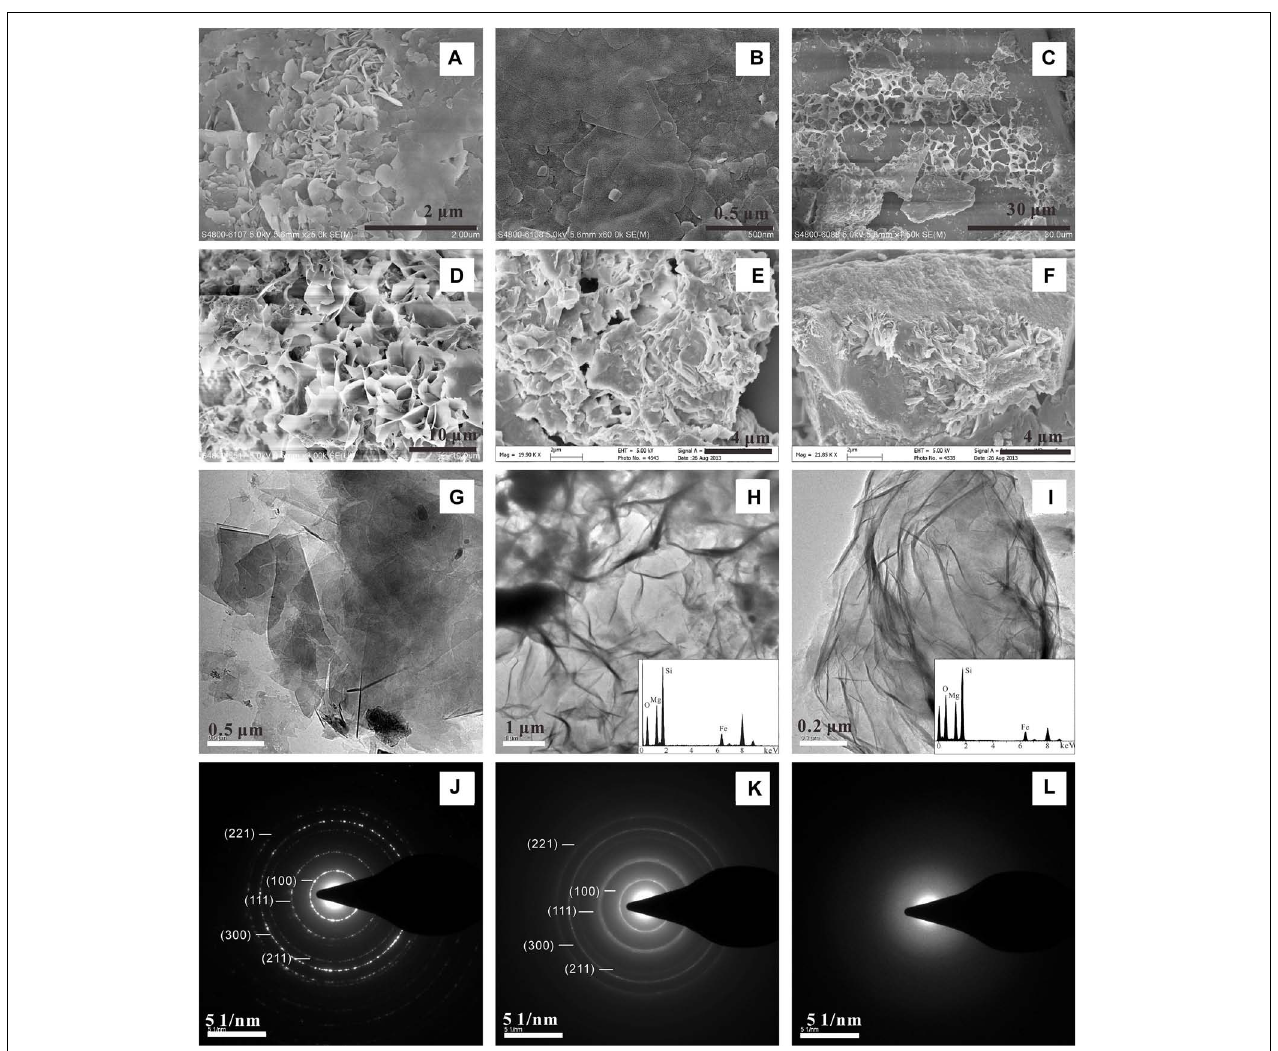
FIGURE 4 | SEM (A–F) and TEM (G–I) characterizations of Mg–Fe smectite produced in [H 2 O-CO 2 ]-peridotite system. The SAED patterns show well crystallized (J,K) Mg–Fe smectite and amorphous (L) Mg–Fe smectite formed in high and low temperature experiments, respectively.